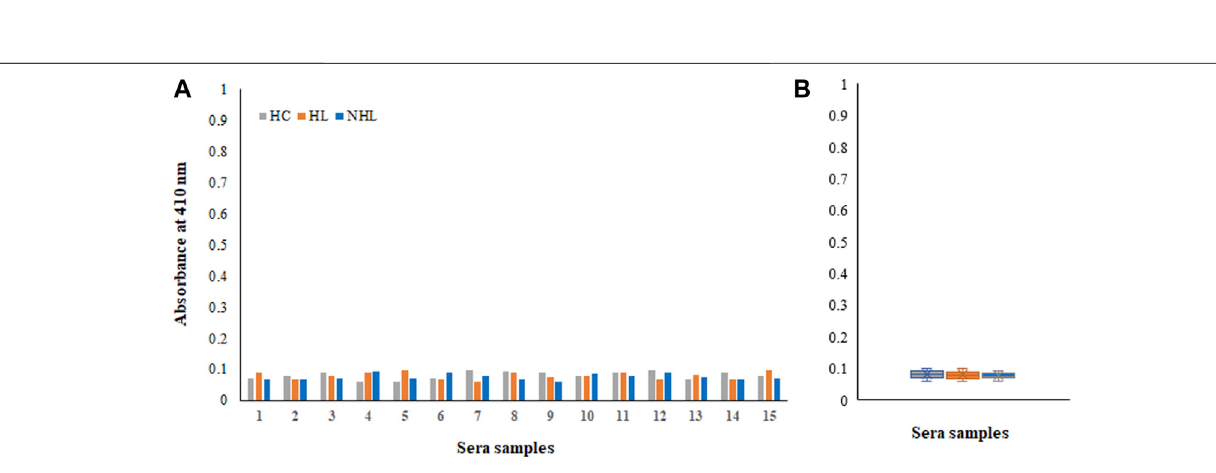
FIGURE5| Detection ofautoantibodies in serum samplesfrom Hodgkin lymphoma (HL), non-Hodgkinlymphoma (NHL) and healthycontrol (HC) subjectsagainst the non-modi fi ed His-H1 protein antigen using direct binding ELISA (A) . Range of absorbance for the autoantibody levels in all subjects (B)